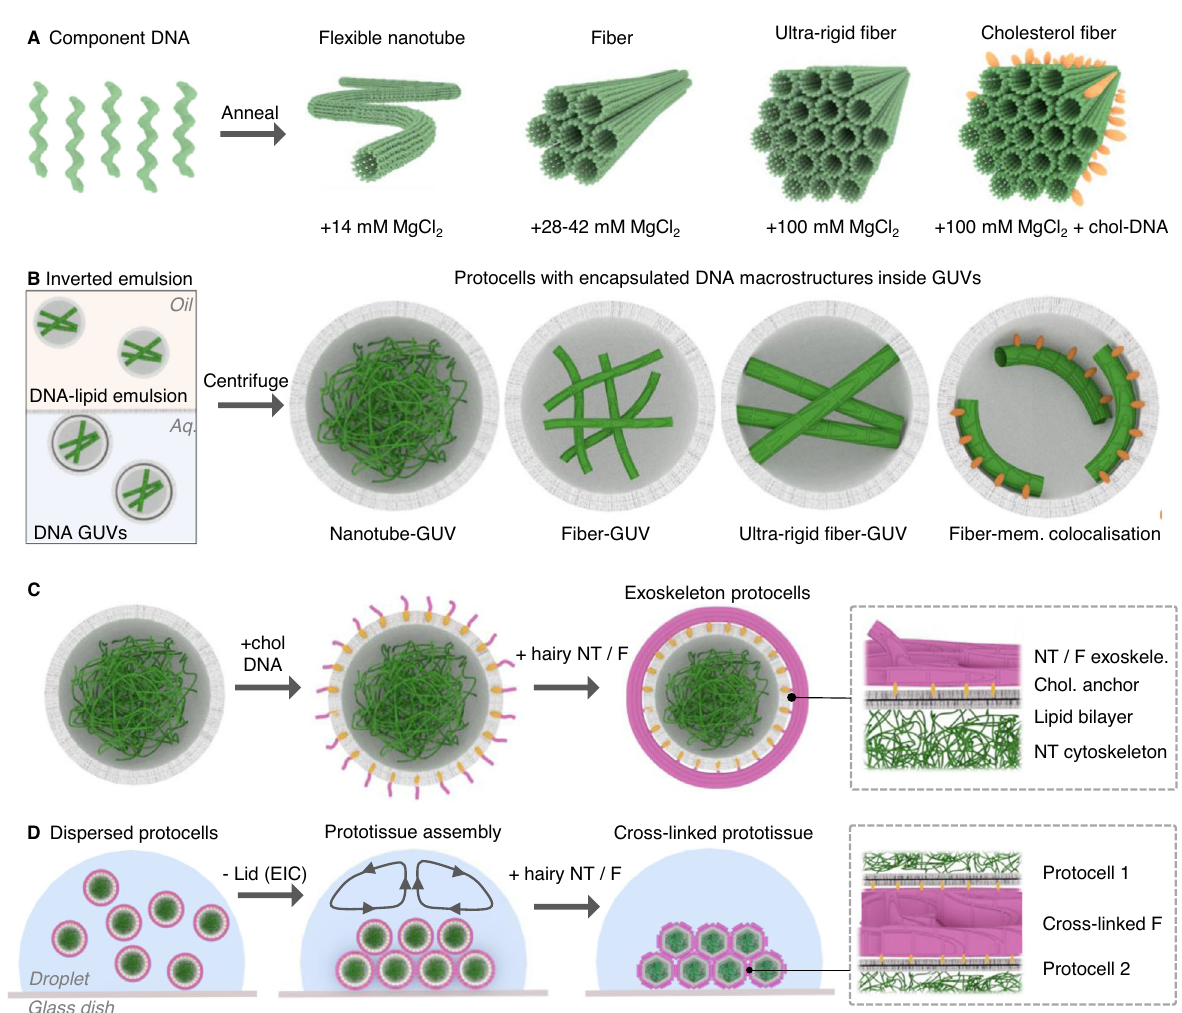
Fig.1|OverviewofproceduretoconstructDNAcyto-orexoskeletalprotocells and prototissues. A Five component oligonucleotides anneal to form DNA nano- tubes (NT), or fi bers (F) (green) atdifferent MgCl 2 concentrations, DNA nanotubes form at14mM MgCl 2 , while fi berswith increasing diameter and stiffnesses format higher Mg concentrations, left to right, and cholesterol-labeled (orange ellipsoids) 100mM MgCl 2 DNA fi bers, far right. B Protocells generated using an inverted emulsion procedure enable DNA macrostructures to becompartmentalized inside GUVs. DNA structures (green) in aqueous buffer are added to a lipid-oil layer (yellow box) which forms an emulsion droplet (gray sphere) surrounded by a lipid monolayer. Upon centrifugation, thedense droplets migrate to the aqueous phase (blue box), which is covered in a lipid monolayer (gray line) to form lipid bilayer